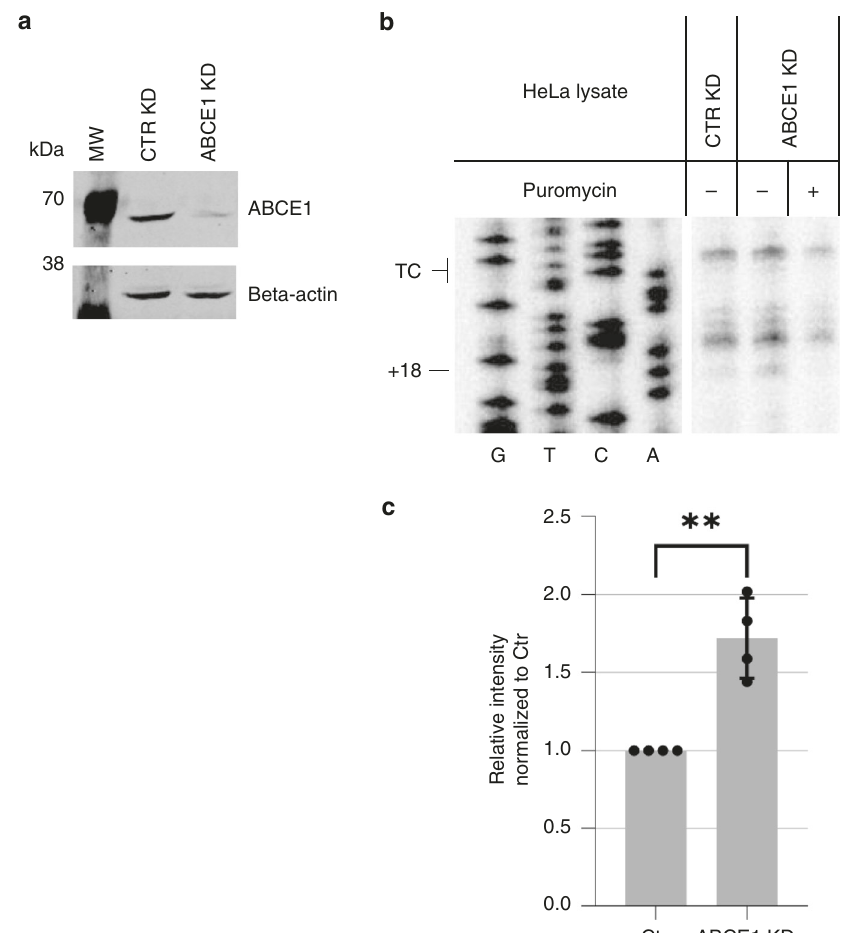
Fig. 3 Increased ribosome occupancy at the TC of in vitro translated mRNAs under decreased concentrations of the recycling factor ABCE1. a Western blot analysis of ABCE1 depletion in HeLa lysates. Cell lysates equivalent to 4 × 10 5 cells treated with a CTR or ABCE1 siRNAs were loaded on a 10% SDS- PAGE, transferred onto a nitrocellulose membrane and probed for ABCE1 and beta-actin. b Toeprint analysis of ribosome occupancy at the TC under ABCE1 depletion was performed after in vitro translation of the 200 + pA construct for 50 min at 33 °C in lysates from cells treated with CTR or ABCE1 siRNAs. Sanger sequencing reactions were run in parallel (G, T, C, A) to locate the positions of the toeprints. The position of the TC and the toeprint band corresponding to the ribosomes at the TC ( + 18) are indicated. c Relative quanti fi cation of the translation-dependent + 18 band under ABCE1 conditions of 4 independent toeprinting experiments, normalized to the translation-independent mRNA signals and to the values of the Ctr KD conditions. Mean values ± standard deviation are shown and the values of the individual experiments are depicted by dots (Unpaired, two-sided statistical t -test: Ctr/ABCE1 p value: 0,0014). Source data are provided as a Source Data